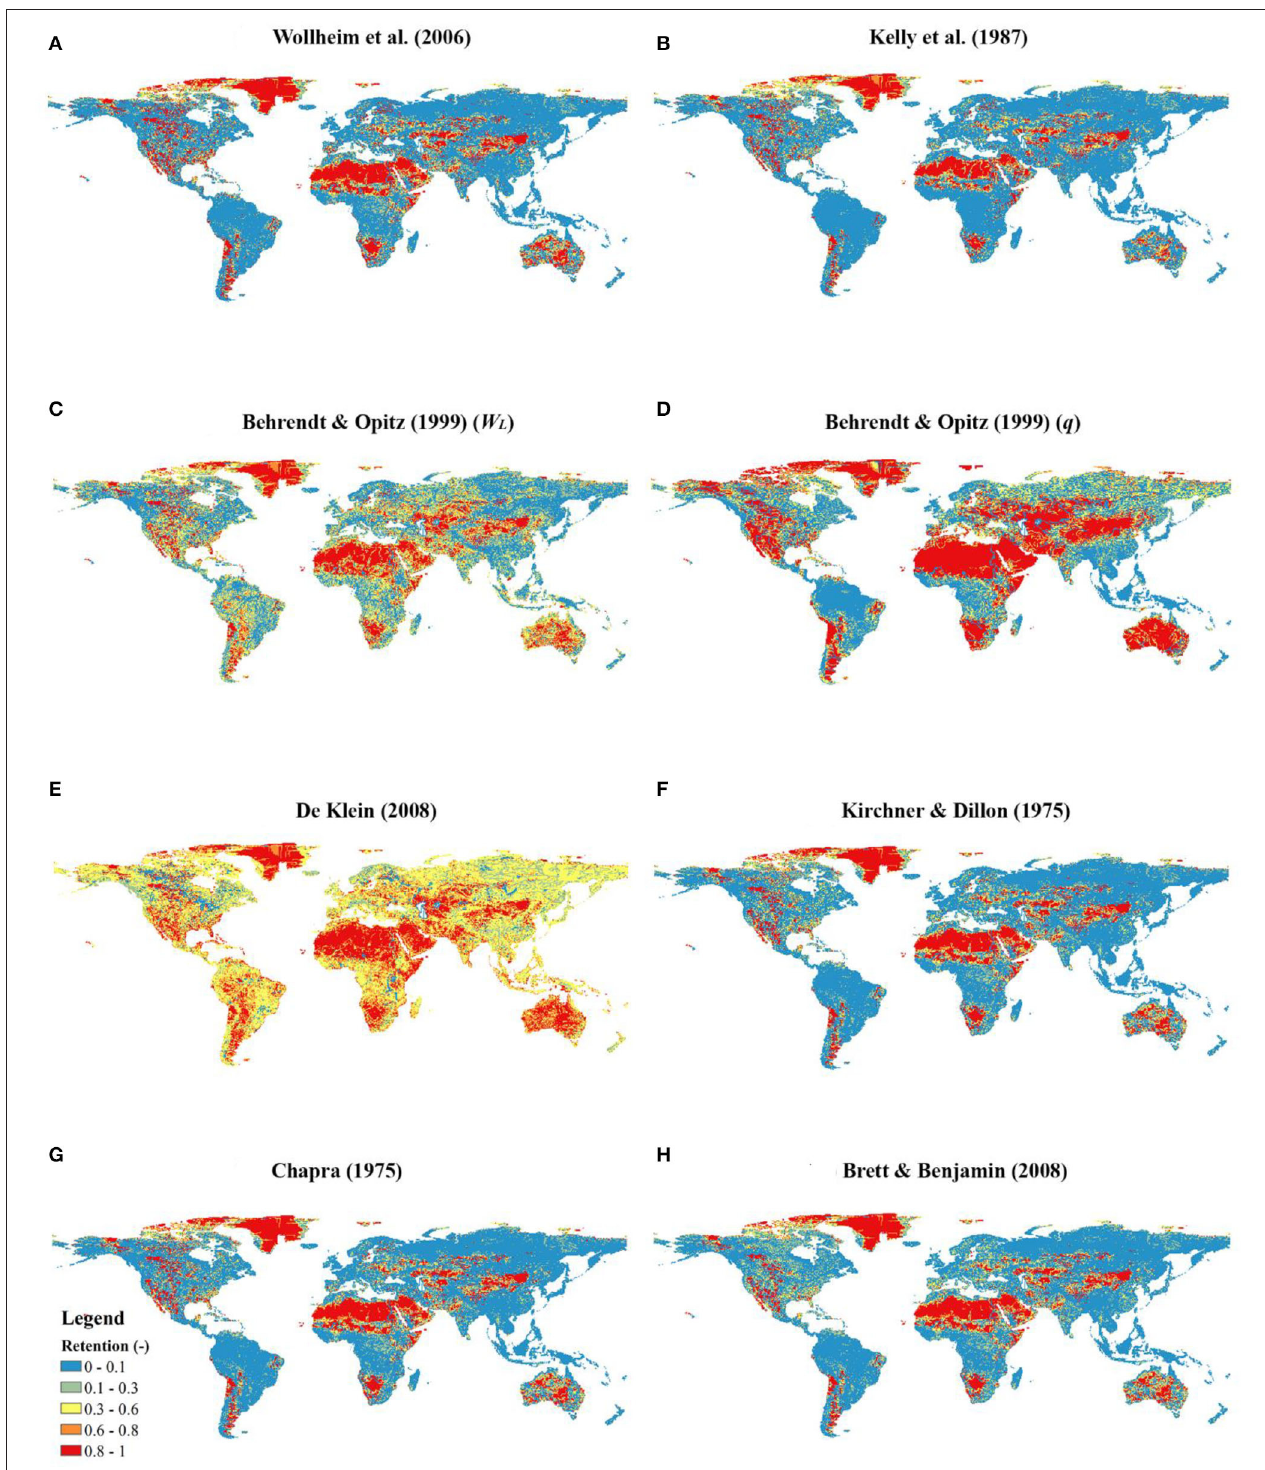
FIGURE 6 | P retention maps for different models at a half-degree resolution (Retention is dimensionless, and the unit was labeled as “-”). (A–H) indicate the plots of different retention models.